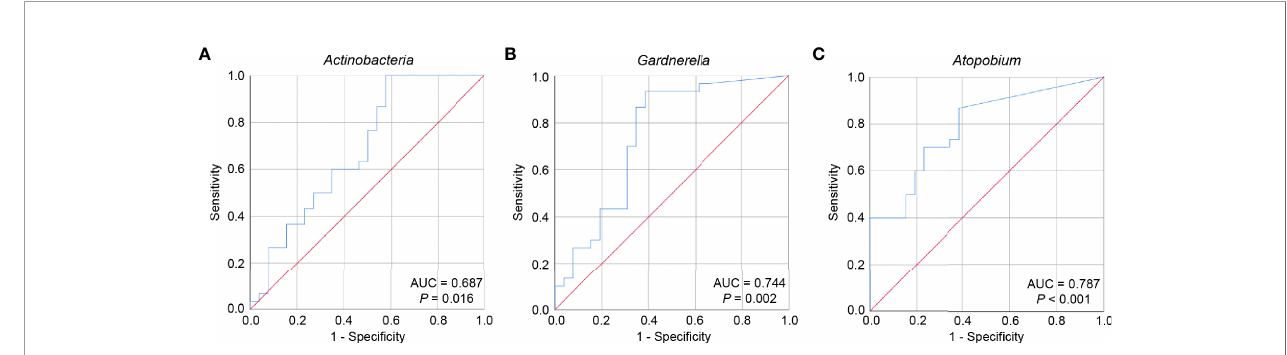
FIGURE 5 | The potential of key bacterial taxa to predict POI. ROC curves were constructed and AUC values were calculated to assess the potential of predicting POI for Actinobacteria (A) , Gardnerella (B) , and Atopobium (C) . ROC, receiver operating characteristic; AUC, area under the